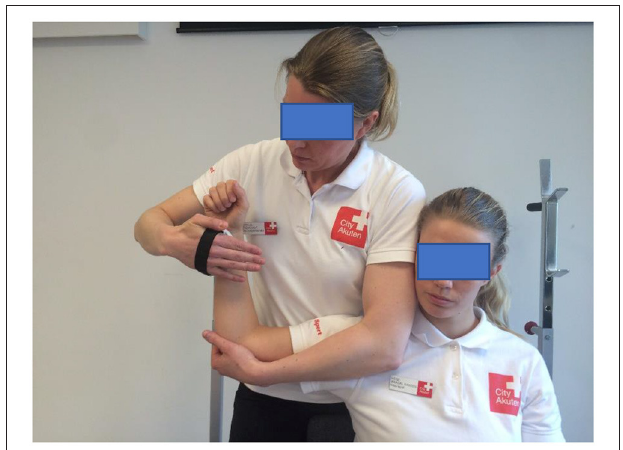
FIGURE 2 | Measurement of isometric muscle strength of the external rotators and starting position for eccentric strength measurement using a hand-held dynamometer (CompuFET, Hoggan Health Industries Inc., Groningen, The